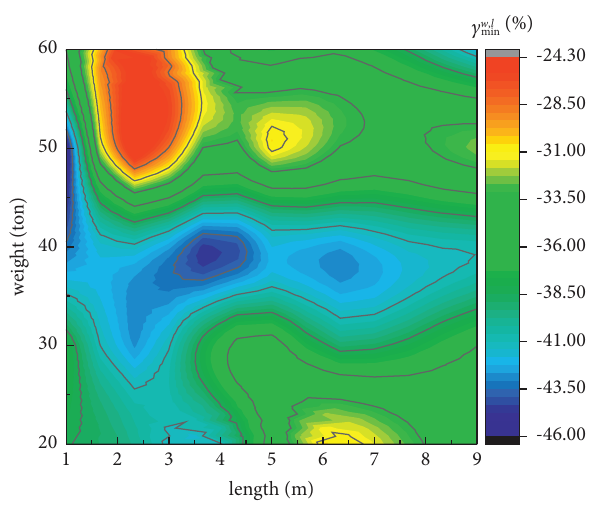
values of the shell members. max